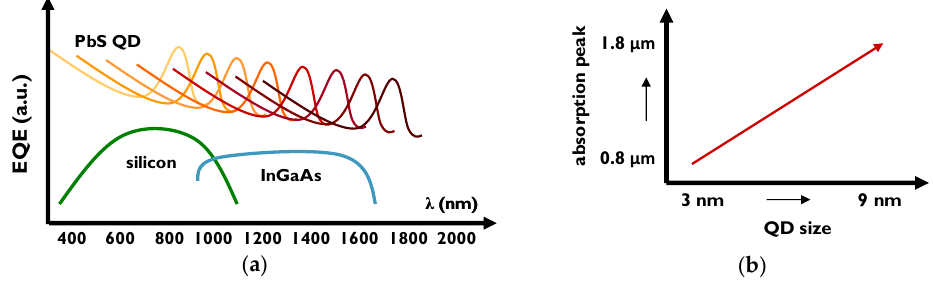
Figure 3. Schematic external quantum efficiency curves for silicon, InGaAs and PbS QD photodetectors ( a ) and indicative absorption peak dependence on quantum dot size ( b ).